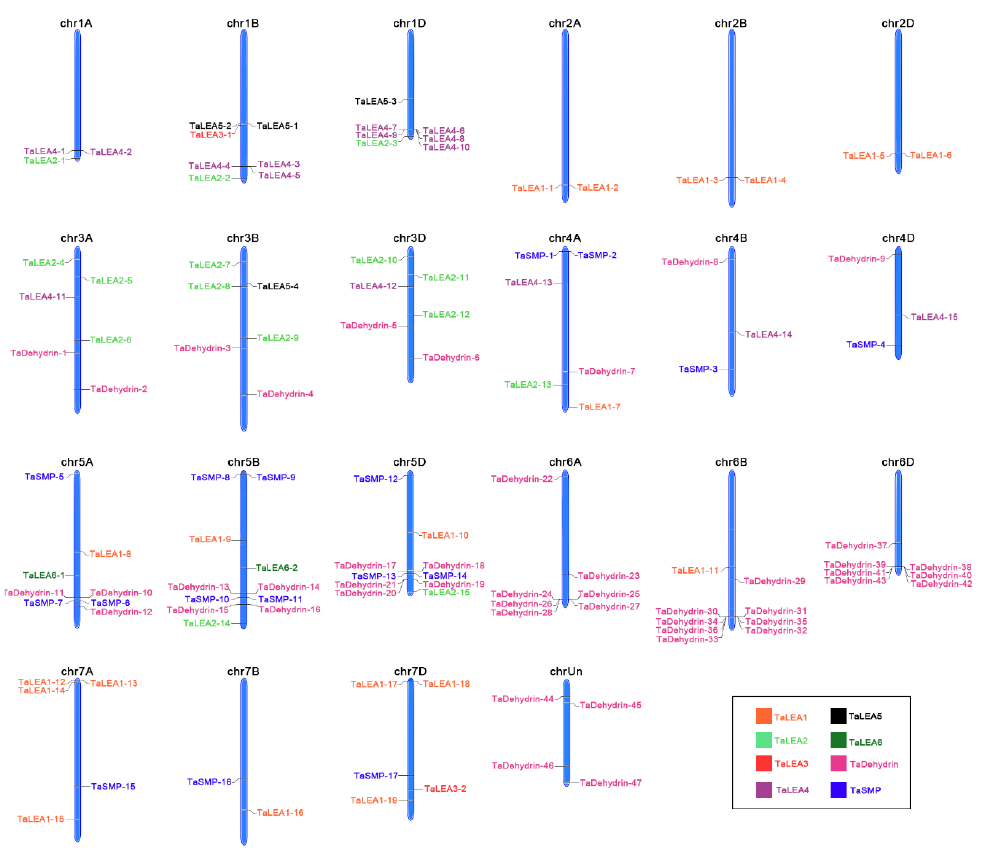
Figure 4. Distribution of TaLEA gene family members on wheat chromosomes. TaLEA1 , TaLEA2 , TaLEA3 , TaLEA4 , TaLEA5 , TaLEA6 , TaDehydrin and TaSMP subfamily are presented in orange, light green, red, purple, black, dark green, pink, and blue.